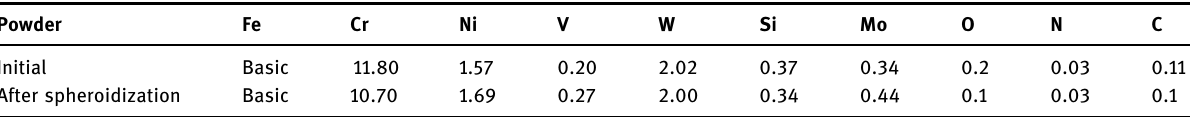
Table 2: Chemical composition of the powder ( wt% ) Powder Fe Cr